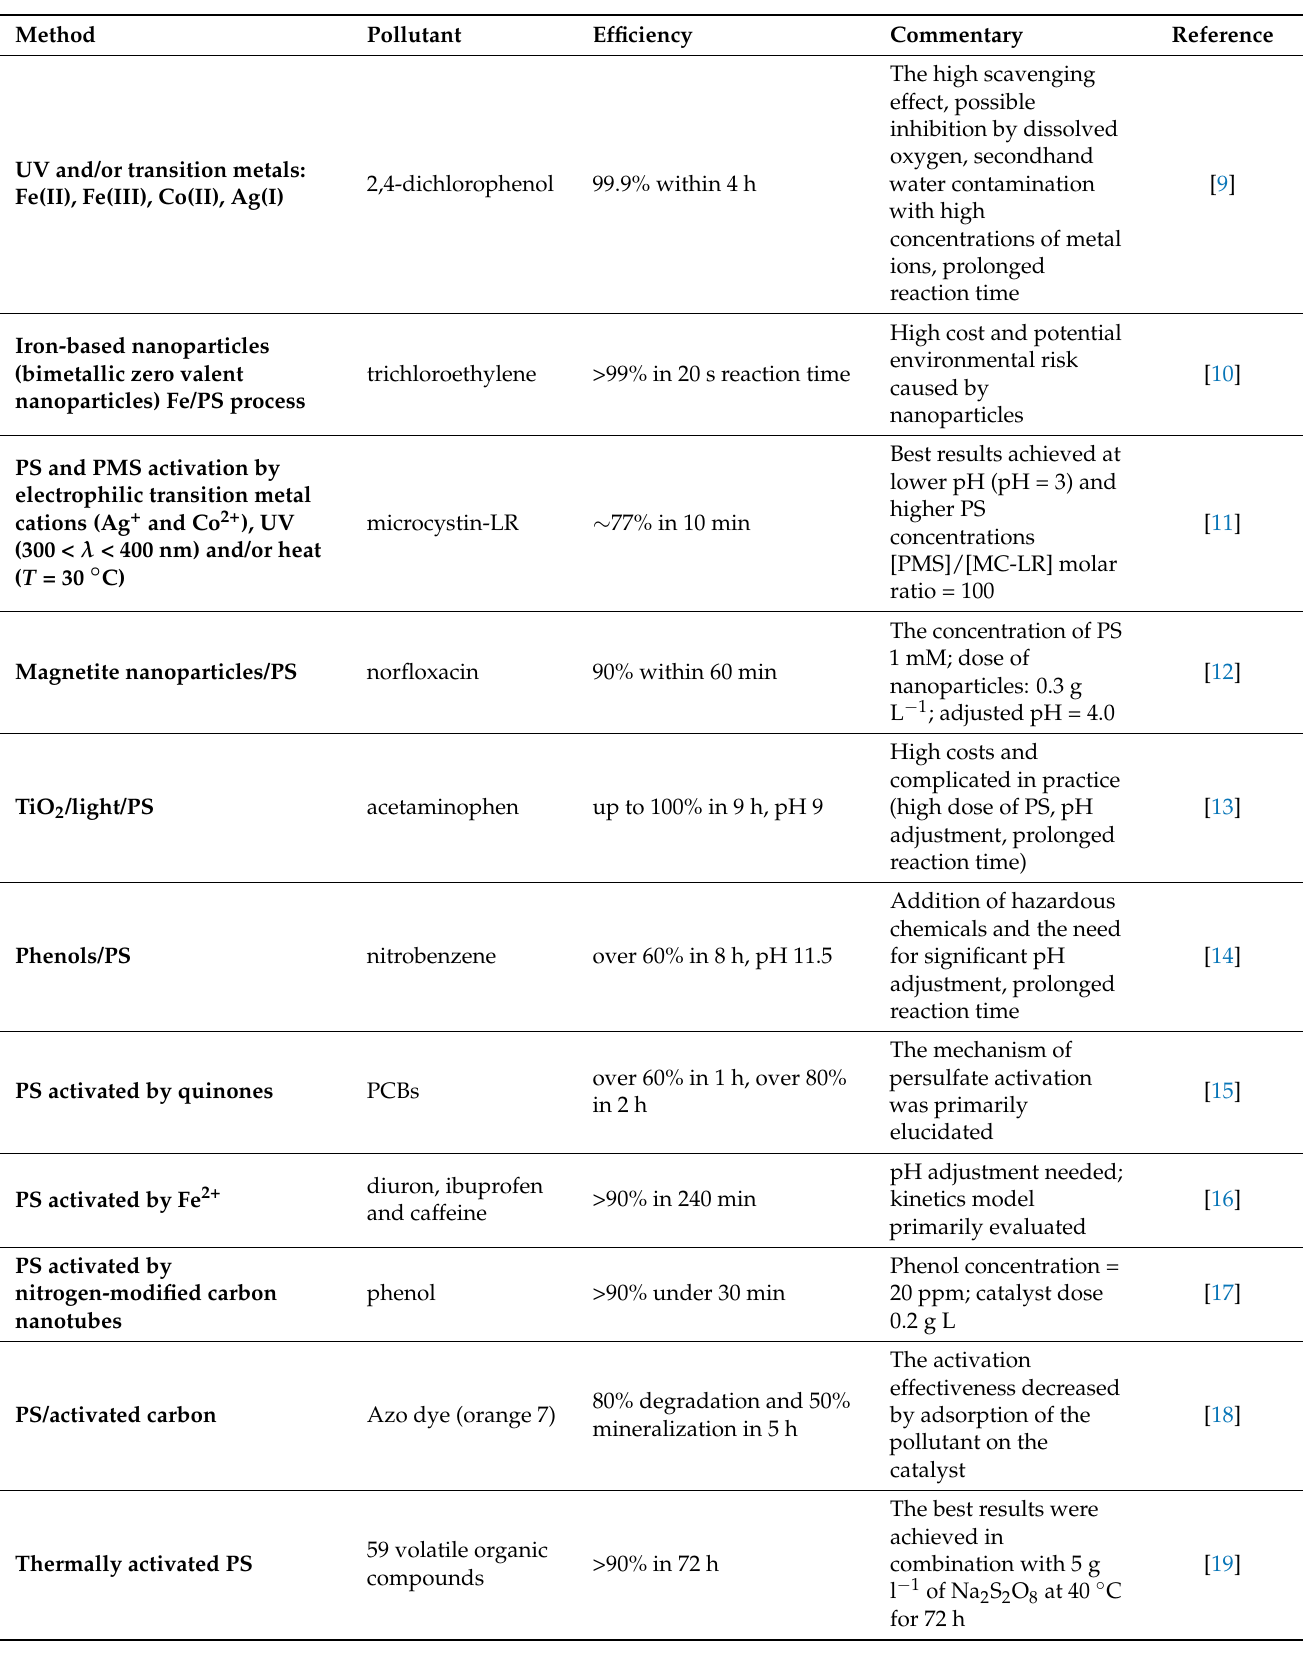
Table 1. Examples of PS activation